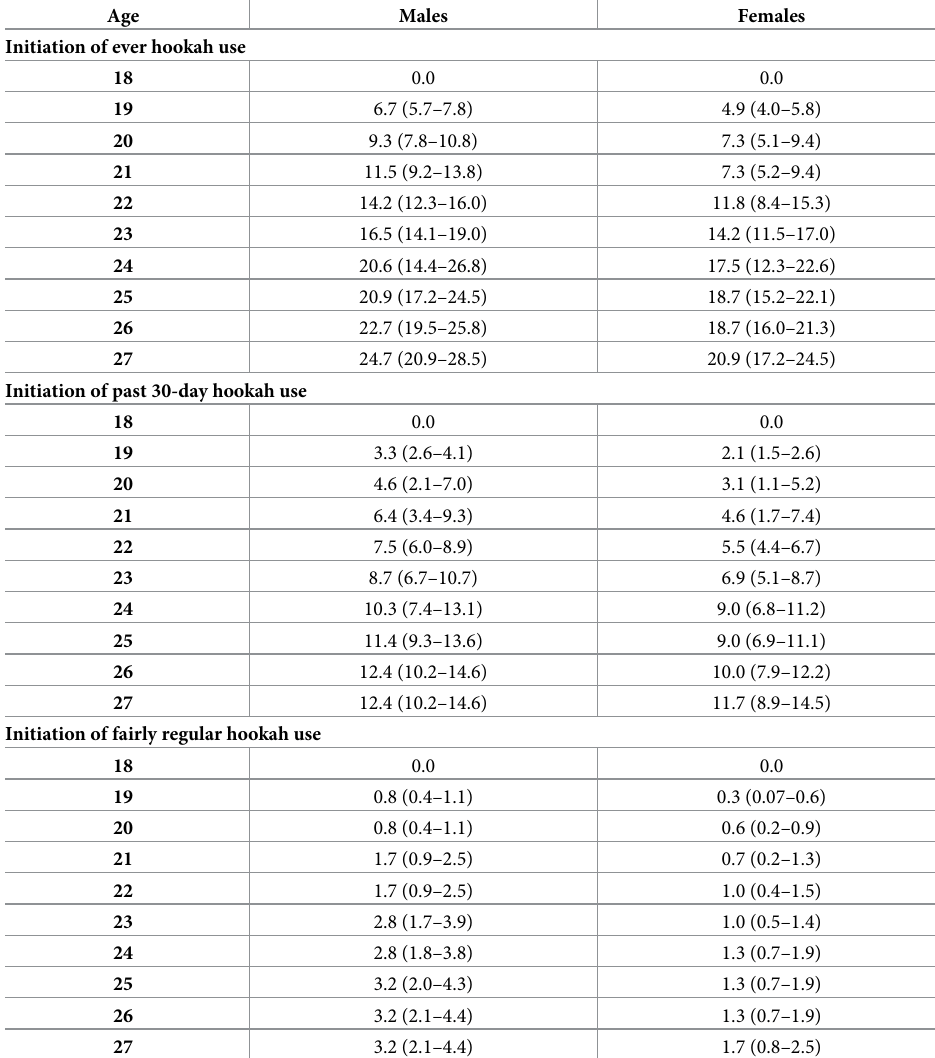
Table 4. Estimated hazard functions a (and 95% confidence intervals b ) of the age of initiation of each hookah use behaviors for the overall sample of PATH¥ young adult (aged 18–24) by